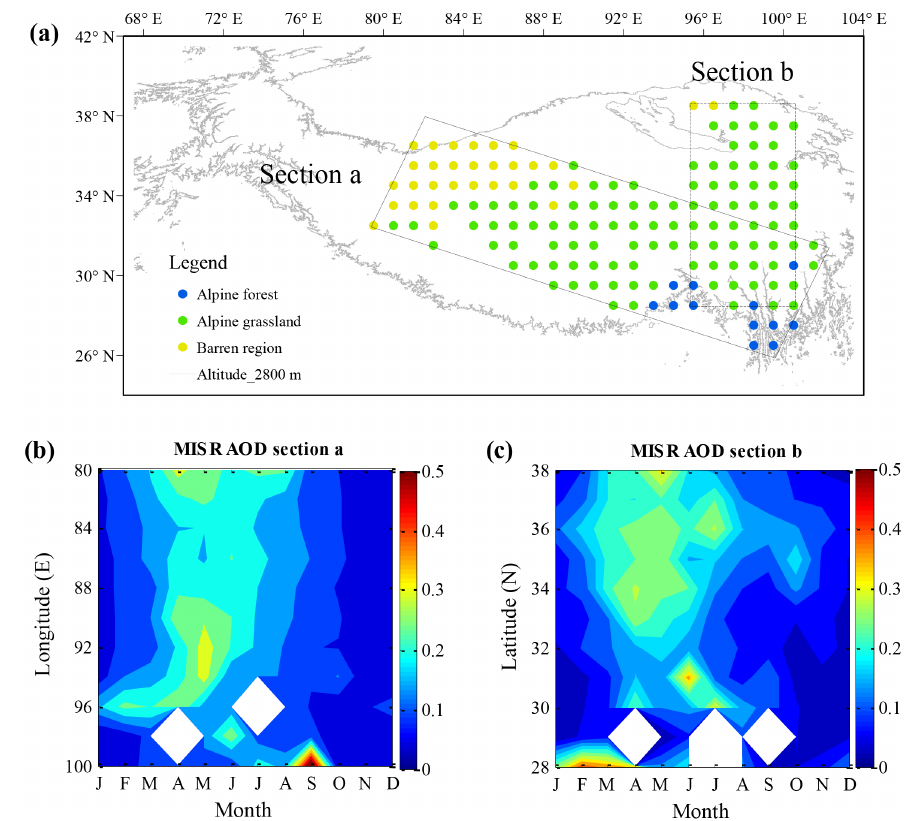
Figure 12. Mean MISR AOD (at 550nm) for two cross-sections during various months in the 2011–2013 period. Missing datasets are plotted in white. The longitudinal section a is from the southeast (100 ◦ E, 25.5 ◦ N–102 ◦ E, 31.5 ◦ N) to the northwest (79.5 ◦ E, 32.5 ◦ N–81.5 ◦ E, 38.5 ◦ N); the latitudinal section b is from the south (95 ◦ E, 28 ◦ N–101 ◦ E, 28 ◦ N) to the north (95 ◦ E, 39 ◦ N–101 ◦ E, 39 ◦ N). J–D stands for the months of